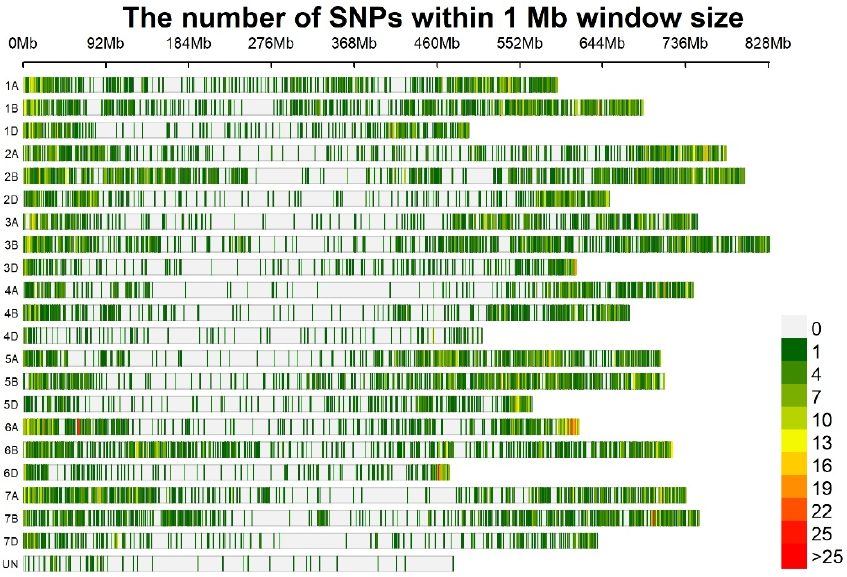
Figure 5. Linkage disequilibrium decay for A genome ( A ), B genome ( B ), and D genome ( C ) of 200 bread wheat genotypes.